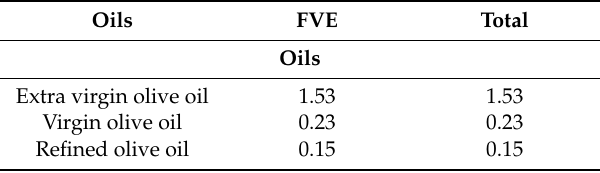
Table 6. Flavonoid contents of oils (mg / 100 g oil) [24].